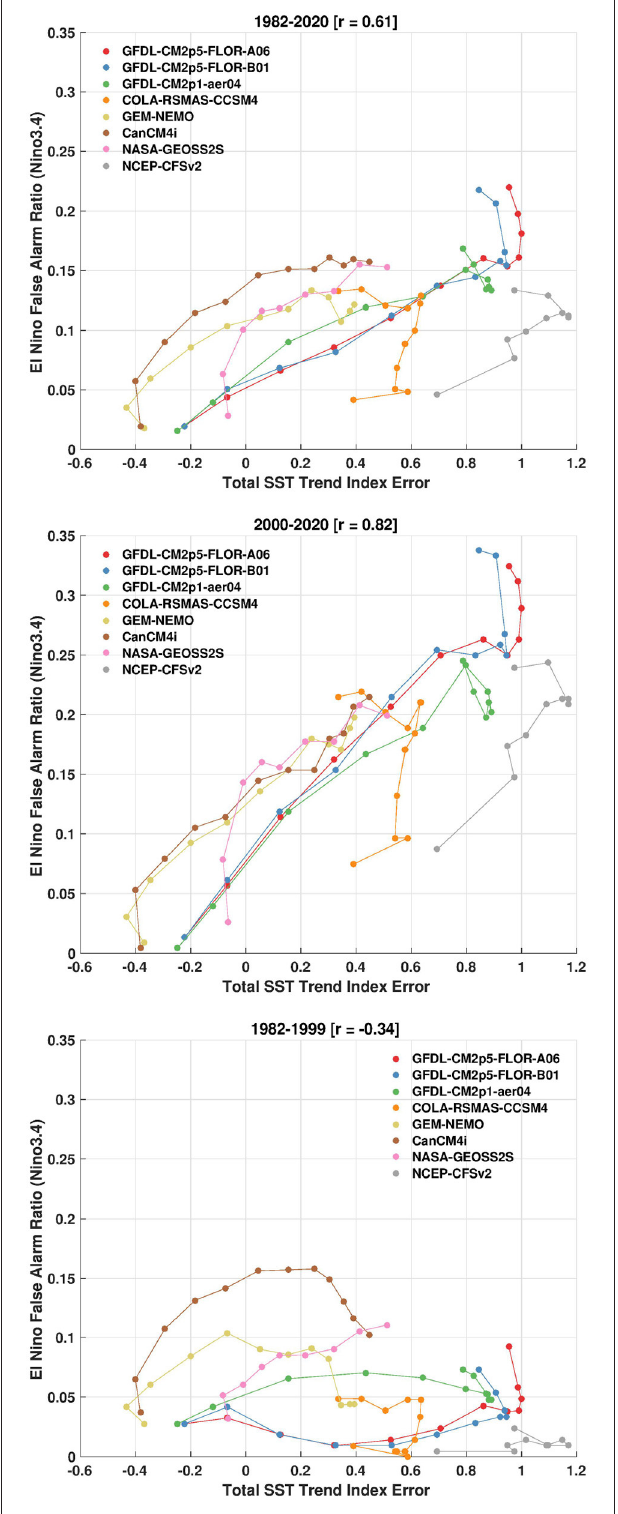
FIGURE 11 | (Top) For the entire 1982–2020 period, scatterplot of the El Niño False Alarm Ratio in NMME (using a +0.5C threshold in the Niño-3.4 SST